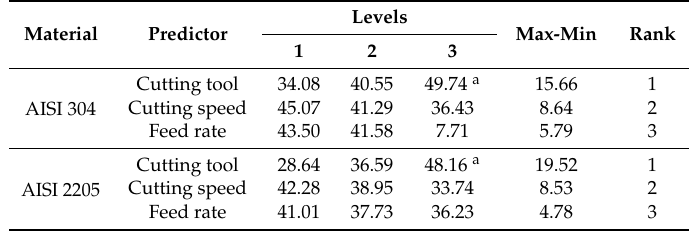
Table 6. Response table mean S/N ratio for tool life factor and significant